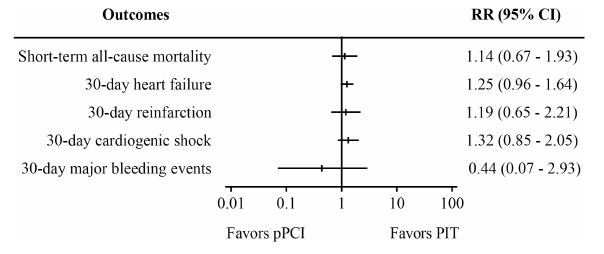
FIGURE 2 | Meta-analysis results of randomized controlled trials. PIT, pharmaco-invasive therapy; pPCI, primary percutaneous coronary